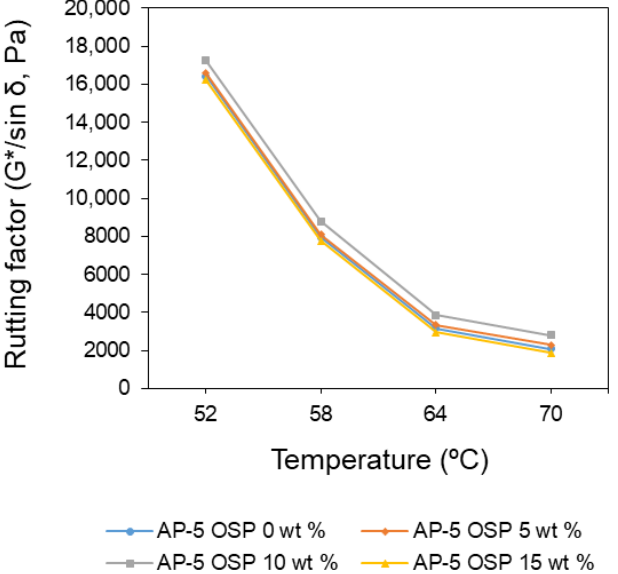
Figure 9. Effect of temperature on the rutting parameter of unfilled and OSP-filled asphalts under short-term aging condition (RTFO: rolling thin-film oven).